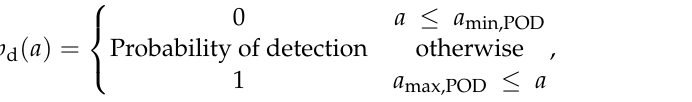
Figure 6. Detection domain through POD.